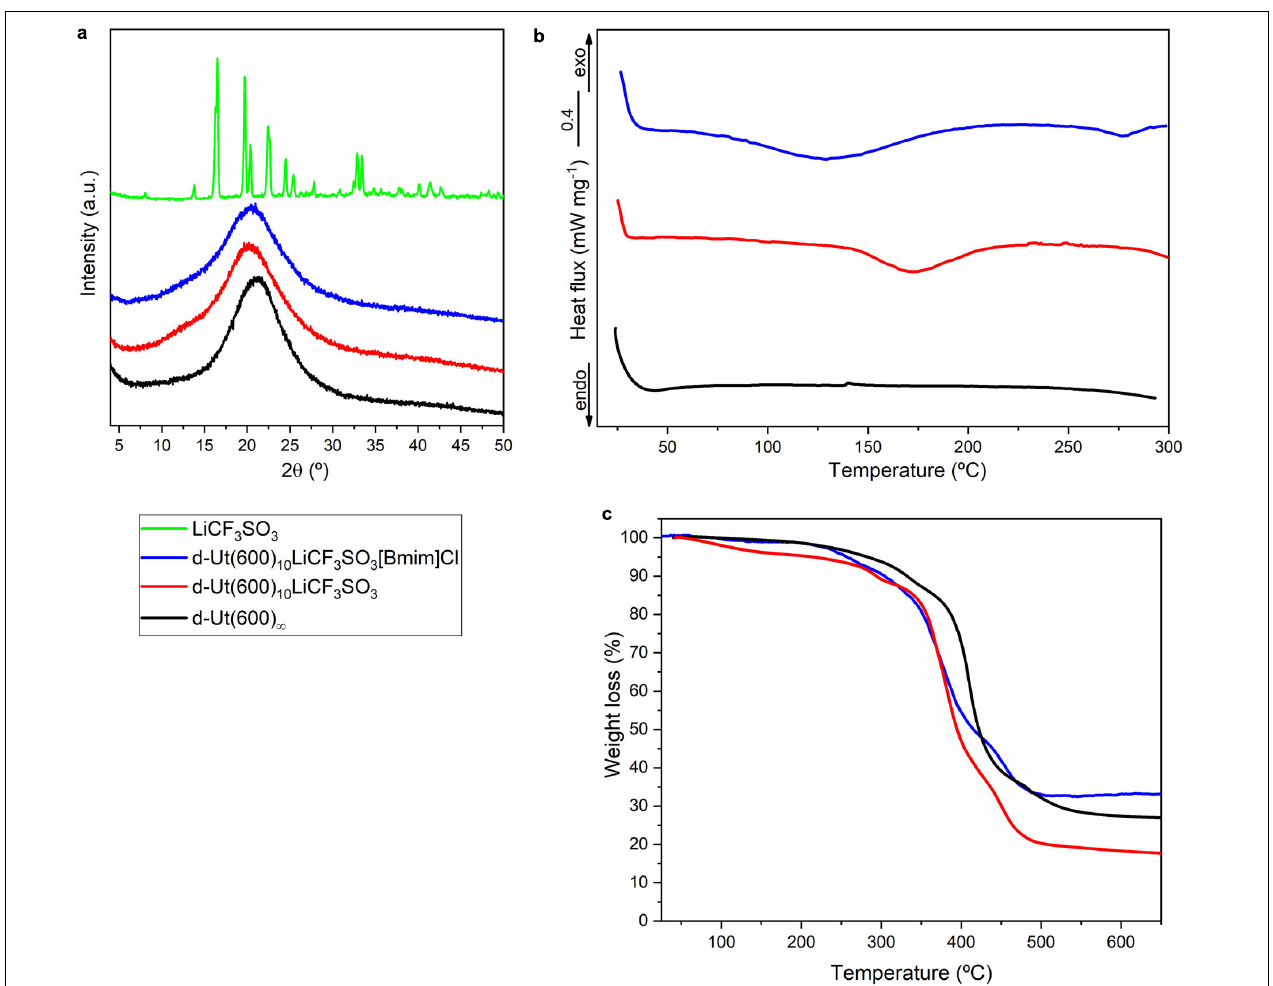
FIGURE 1 | XRD patterns (a) , and DSC (b) and TGA (c) curves of d-Ut(600) ∞ (black line) (Gonçalves et al., 2005), d-Ut(600) 10 LiCF 3 SO 3 (red line) (Gonçalves et al., 2010), d-Ut(600) 10 LiCF 3 SO 3 [Bmim]Cl (blue line), and LiCF 3 SO 3 salt (green line) (Gonçalves et al., 2010).